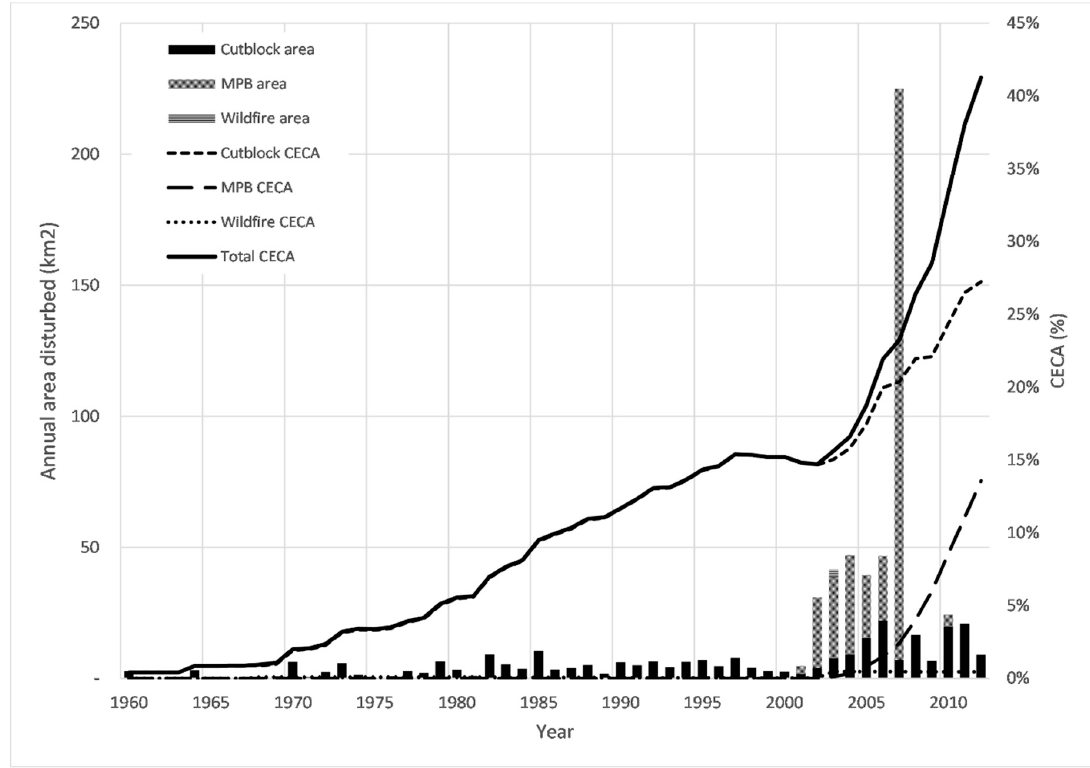
Figure 3 : Annual area disturbed (km 2 ) and Cumulative Equivalent clear-cut area (CECA) in percent (% of watershed area) by disturbance type and total in the Deadman River watershed from 1960 to 2012.